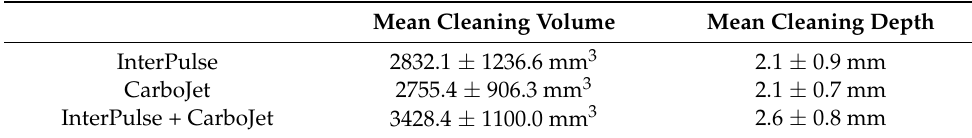
Table 1. Mean cleaning volume and cleaning depth in carbon foam